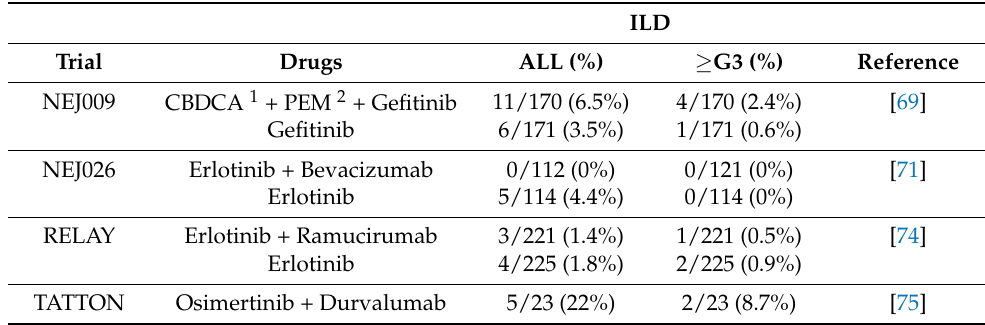
Table 3. Incidence of ILD in the combined therapy with